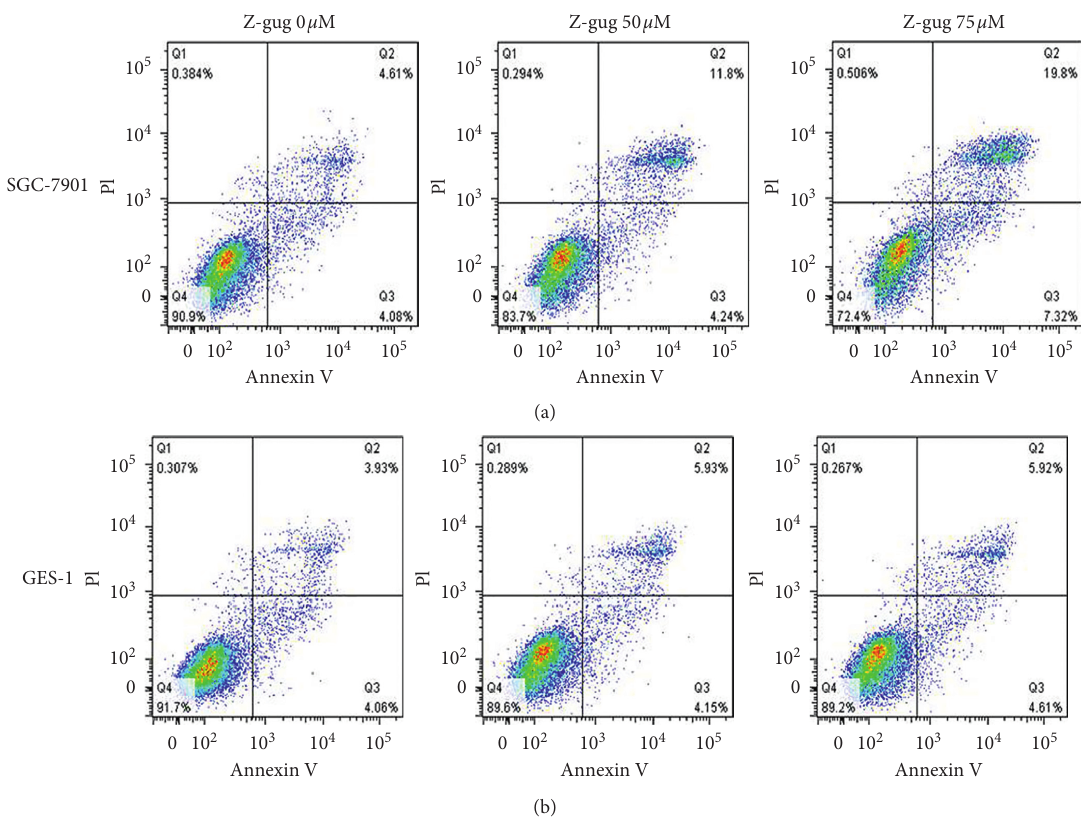
Figure 2: Z-guggulsterone triggered apoptosis in SGC-7901 cells. SGC-7901 (a) and GES-1 (b) cells were incubated with 0, 50, and 75 μ M z- guggulsterone for 24h, and cell apoptosis was investigated by Annexin V/PI staining. Z-gug,